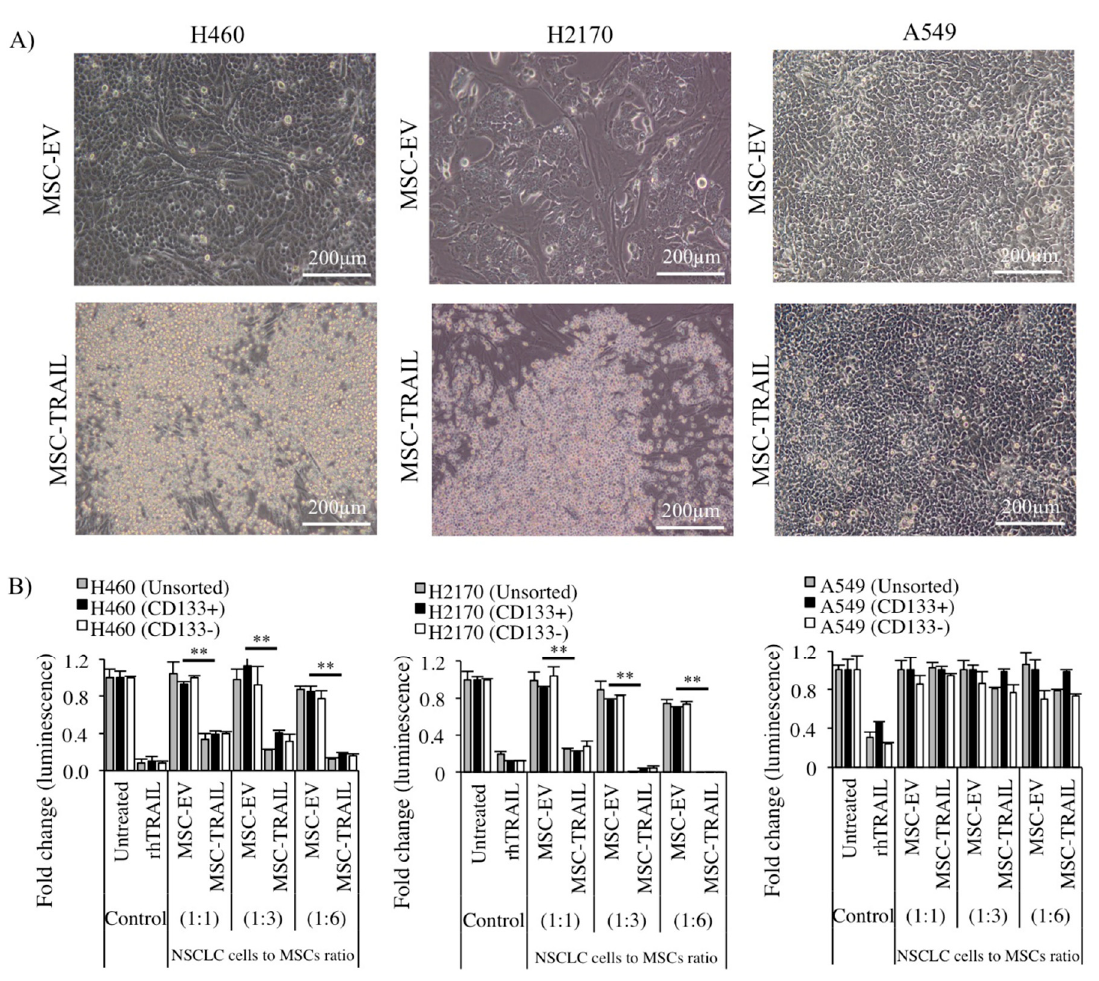
Figure 5. Inhibition of CD133 + CSCs by MSC-TRAIL. ( A ) Representative images taken from phase-contrast microscopy of CD133 + NSCLC (H460, H2170, and A549)-derived CSCs co-cultured with either MSC-TRAIL or MSC-EV. Microscopic examination revealed the presence of dead cells / apoptotic bodies in the CD133 + CSCs derived from H460 and H2170 cell lines treated with MSC-TRAIL. ( B ) The viability of sorted (CD133 + and CD133 − ) and unsorted NSCLC cell lines (H460, H2170, and A549) co-cultured with either MSC-EV or MSC-TRAIL at di ff erent ratios. The rhTRAIL treatment (IC 50 value) was used as the positive control (** p < 0.001; t -test).